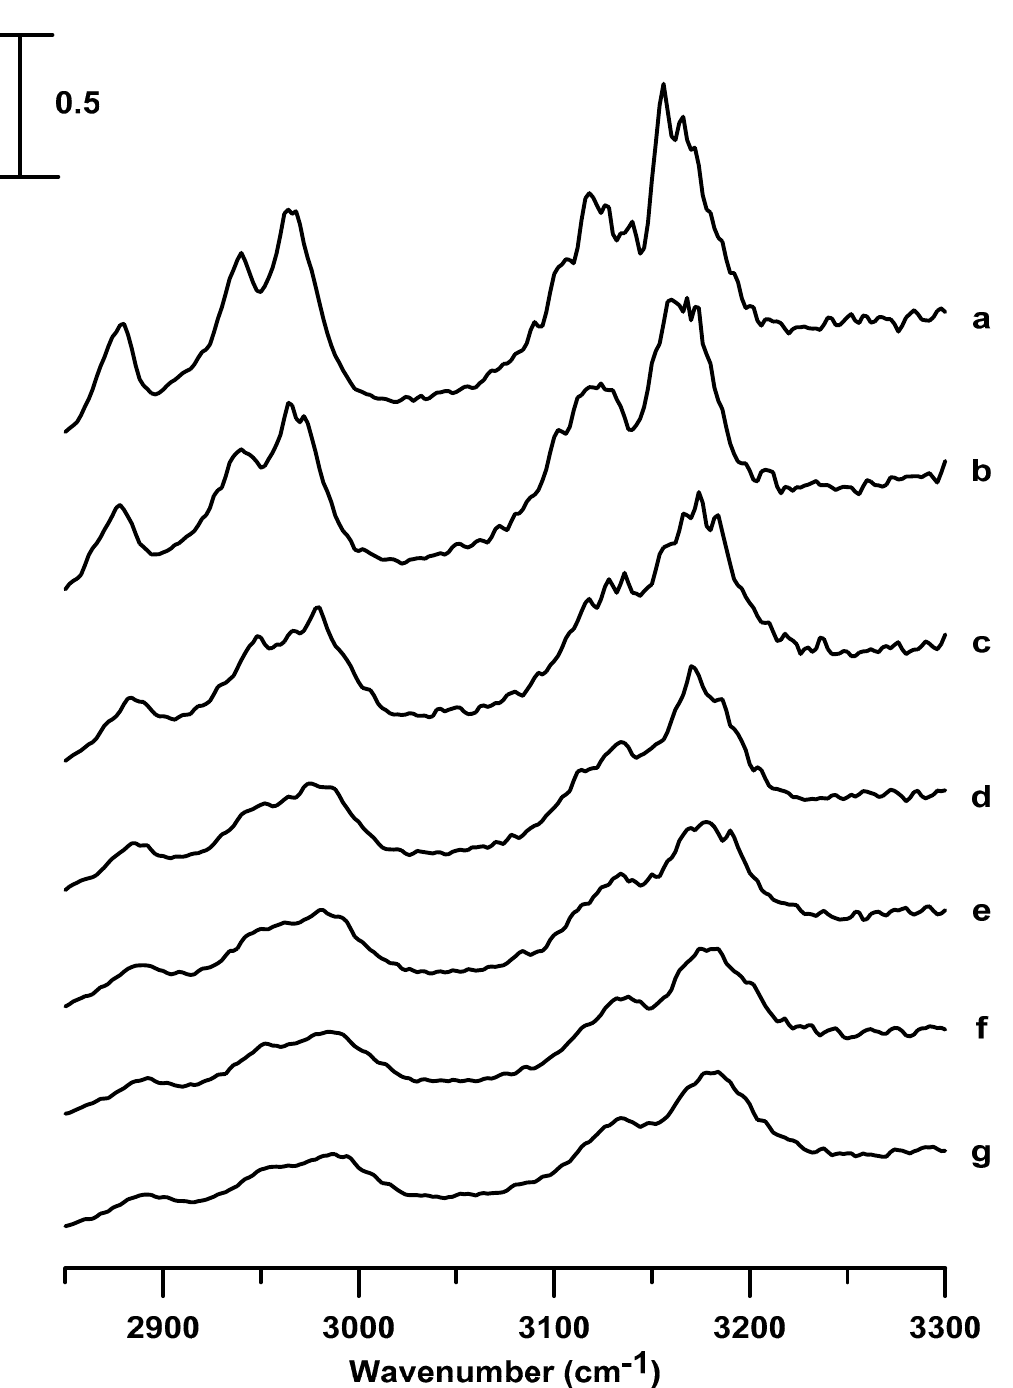
Figure 6. Infrared spectra of [C 4 C 1 Im][BF 4 ] in a silica matrix obtained at (a) ambient pressure and at (b) 0.4, (c) 0.7, (d) 1.1, (e) 1.5, (f) 1.8, and (g) 2.5 GPa.